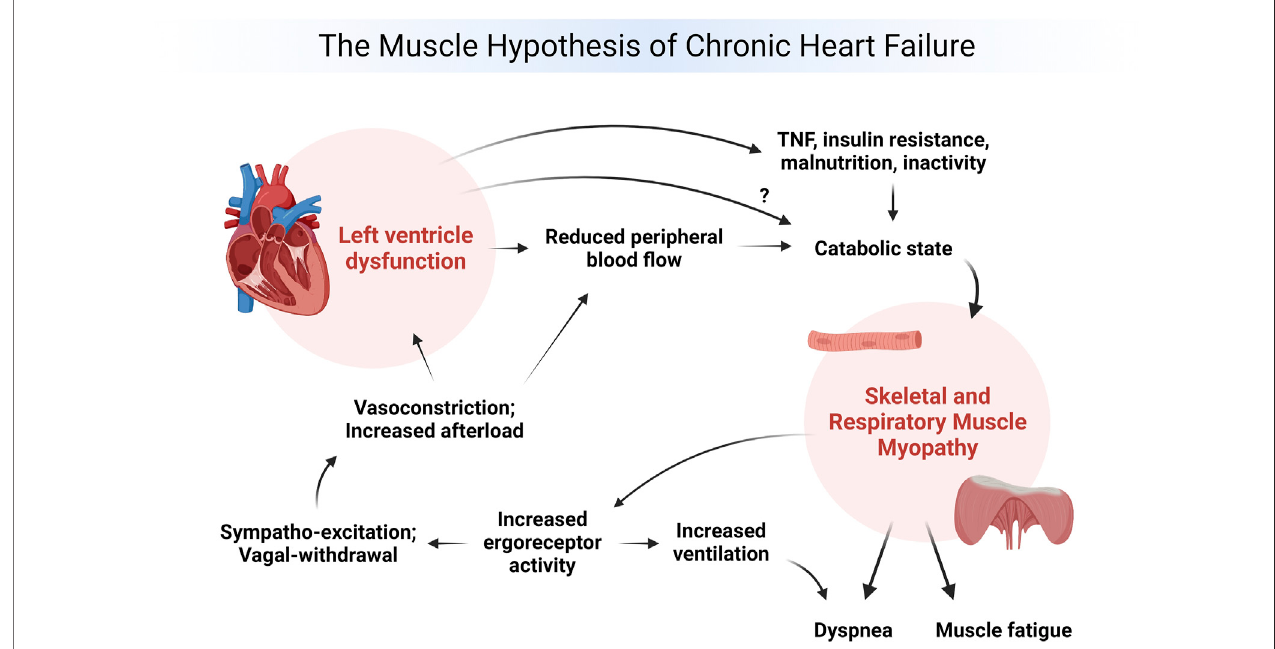
FIGURE 1 | The muscle hypothesis of chronic heart failure (created with